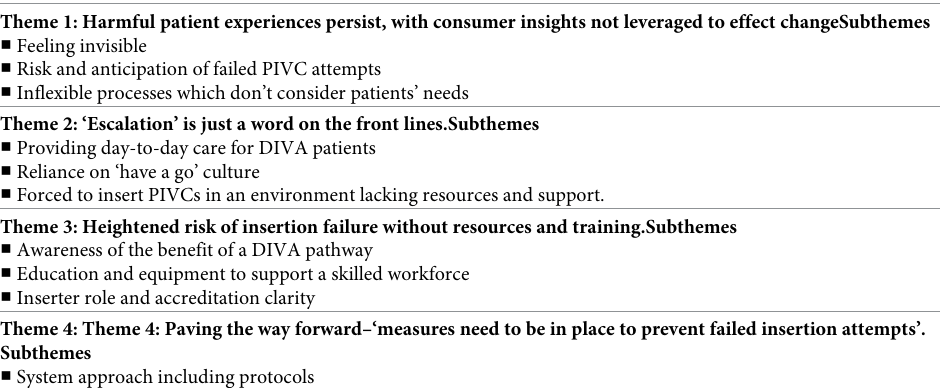
RRMA: Rural, Remote and Metropolitan Area classification; $ =